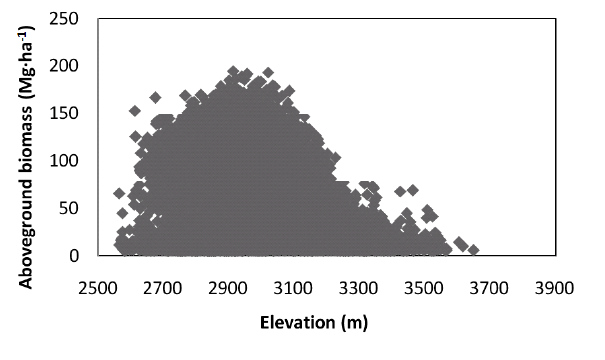
Figure 6. Scatter plots plots comparing above-ground biomass against elevation, slope, and aspect. ( a ) Scatter plot of the above-ground biomass and elevation; ( b ) scatter plot of the above-ground biomass and slope; ( c ) scatter plot of the above-ground biomass and